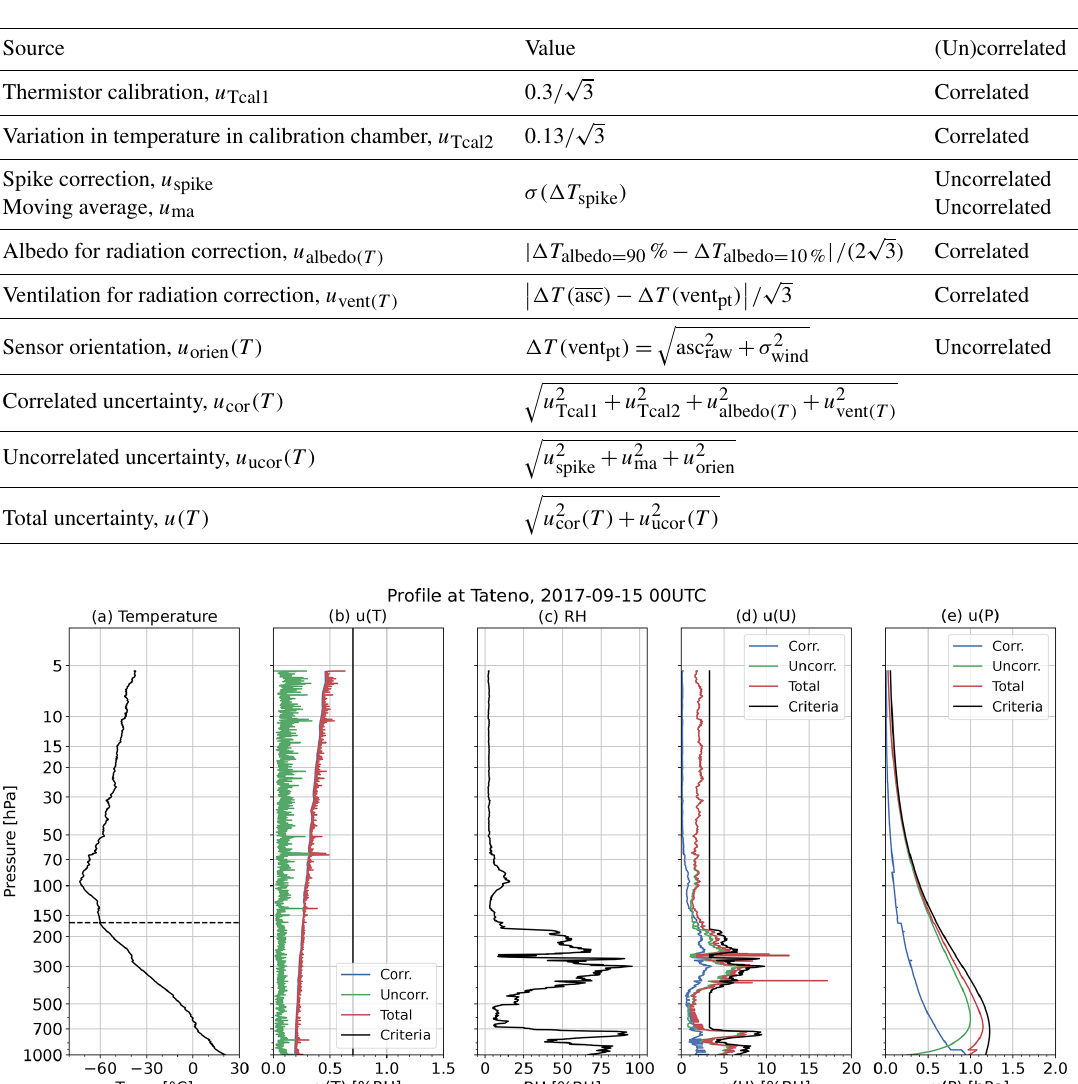
Table 2. Sources contributing to iMS-100 temperature measurement uncertainty.